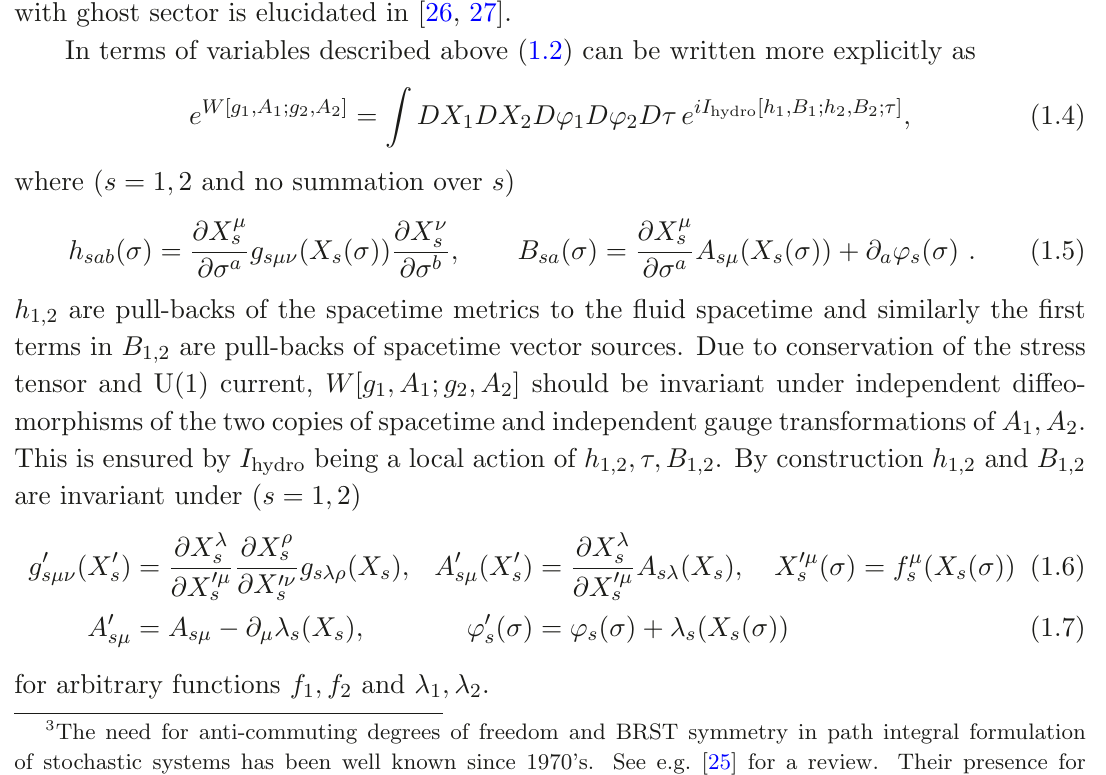
( σ 0 , σ i ) to physical spacetime , 2